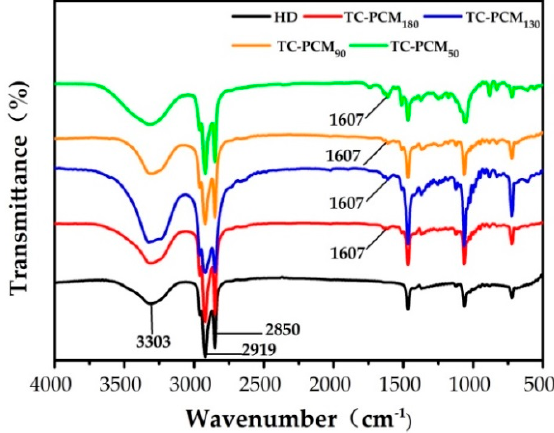
Figure 2. FT-IR spectra of 1-hexadedocanol (1-HD), thermochromic phase change material TC-PCM 180 , TC-PCM 130 , TC-PCM 90 and TC-PCM 50.